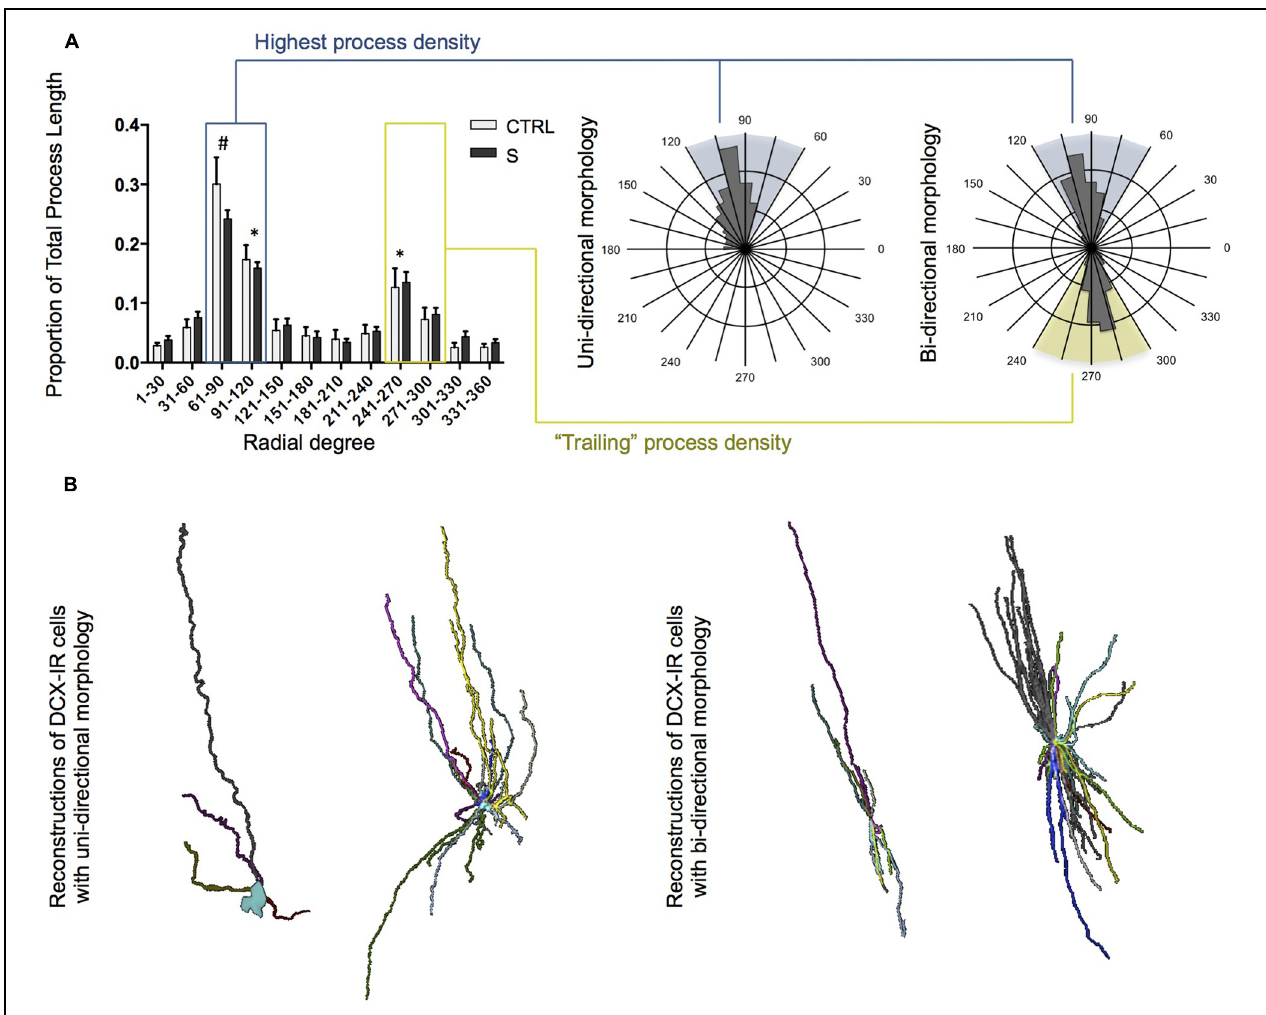
FIGURE 4 | Uni- and bi-directional structure of DCX-IR cells in the OT of suicides (S; n = 6 cells) and controls (CTRL; n = 19 cells). (A) Fan-in analysis and sample radial plots of DCX-IR cells. When plotted, the proportion of total process length per radial degree revealed a bimodal distribution indicating that DCX-IR cells tend toward a uni- or bi-directional structure. Sample radial plots display Fan-in analyses for a uni- and bi-directional cells. Shaded areas correspond to the sextant of highest process density (blue shading and box)